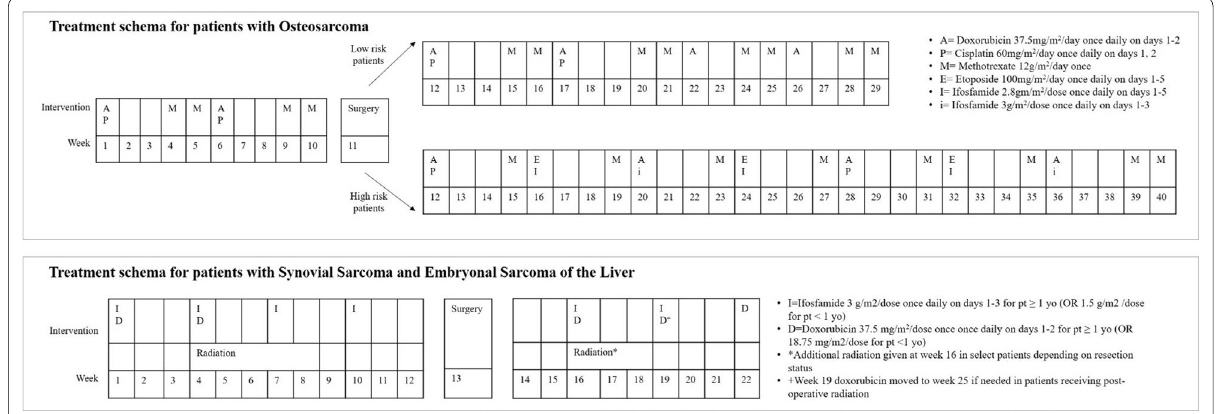
tional file 1: Table S1). None of the PET1, PET2 and ΔPET parameters were associated with OS (Additional file 1: Table S2). Due to the low number of events (8/34